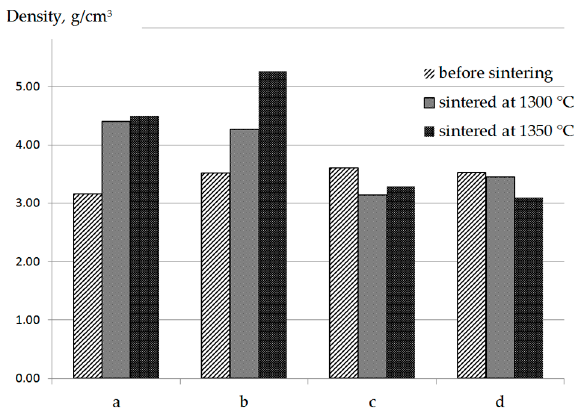
Figure 2. Density change of TiC-Me (titanium carbide with metal binder) compacts sintered at different temperature: ( a ) TiC-50% Ti; ( b ) TiC-50% high-chromium cast iron; ( c ) TiC-50% nickel-based self-fluxing alloy; ( d ) TiC-50% high-speed steel.